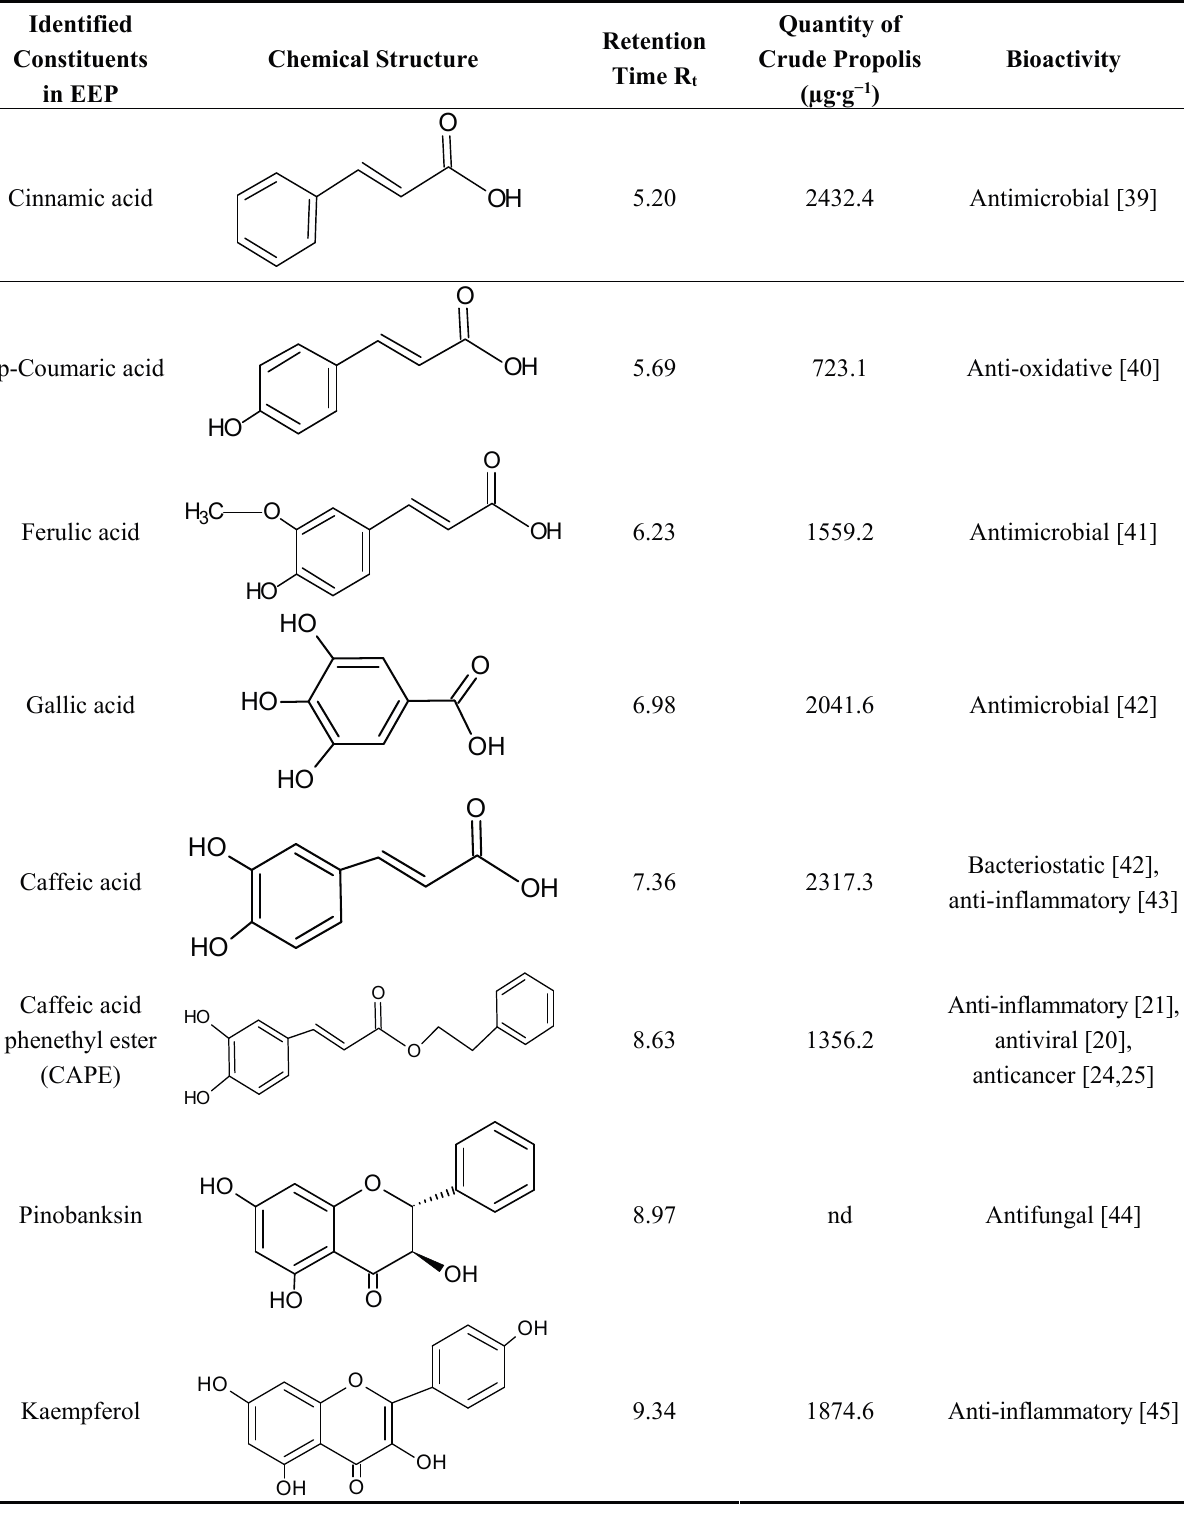
Table 1. The chemical characterization and content of the propolis sample. Data gathered by HPLC-DAD analysis. nd, not detected. EEP, ethanol extract of